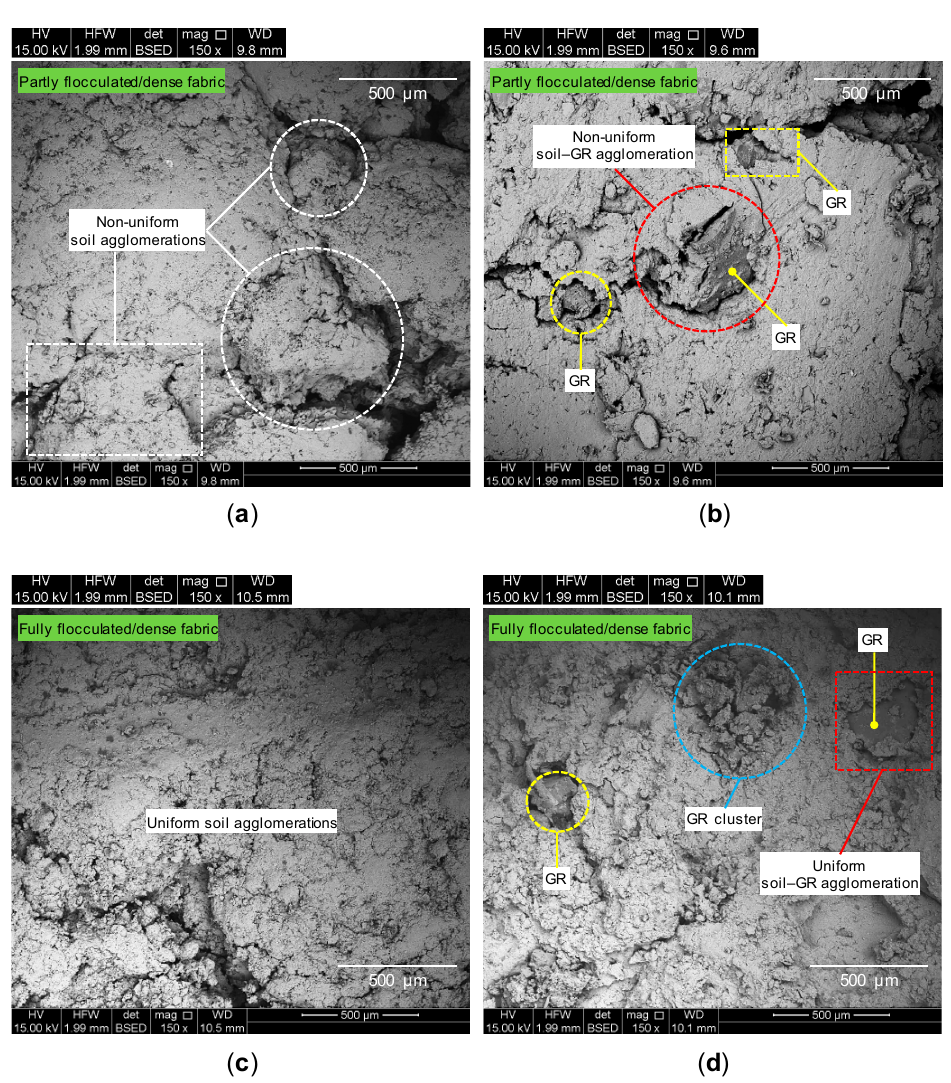
Figure 8. SEM micrographs for the tested samples: ( a ) R 0 S 0 T 0 ; ( b ) R 10 S 0 T 0 ; ( c ) R 0 S 10 T 7 ; and ( d ) R 10 S 10 T 7 .